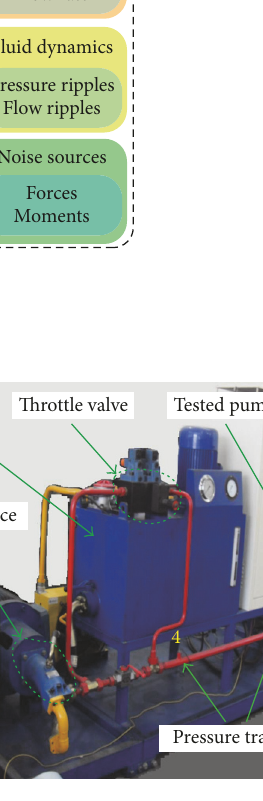
Figure 4: Test rig used to measure the flow